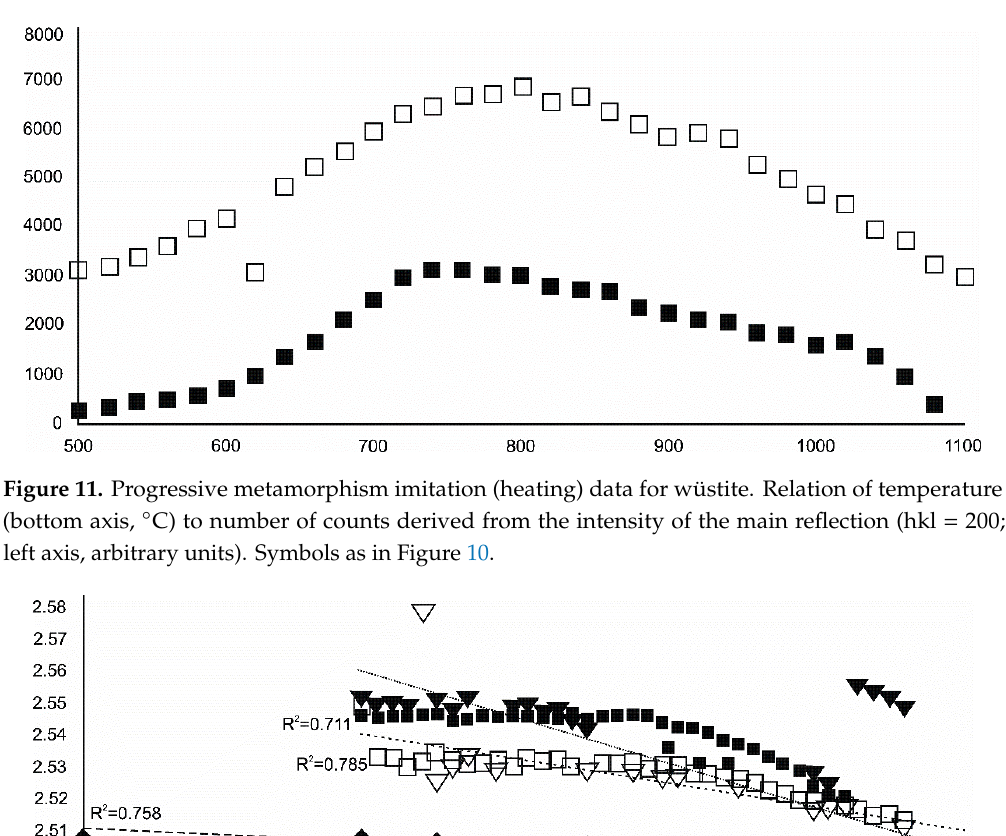
Figure 10. Number of counts (left axis, arbitrary units) versus temperature (bottom axis, °C) for magnetite, as derived from the intensity of the main reflection (hkl = 104). LSCB sample—filled symbols. USCB sample—empty symbols. Heating—squares. Cooling—triangles.